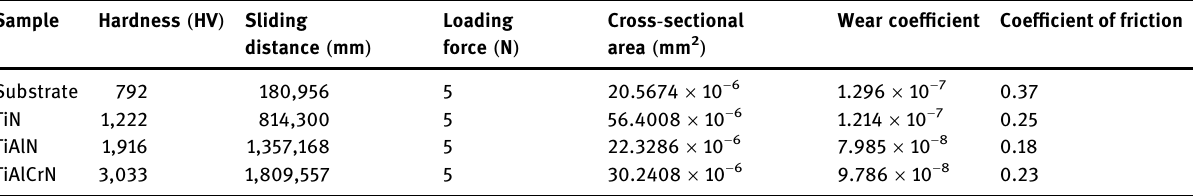
Table 4: Measurement result of related parameters and the calculated wear coe ffi cient